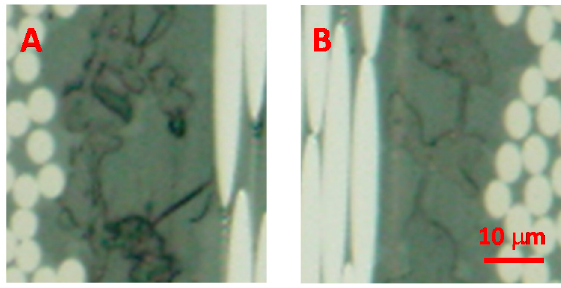
Figure 14. Magnified images of degraded CFRP sample (positions A and B in Figure 13). F igure 14 shows the SAICAS measurement point indicated by red dotted line. SAICAS can measure the cutting force of a blade for a CFRP sample, as indicated in Figure 15. The apparent shear strength can be calculated from the indicated area of the plot of depth versus force, as indicated in equation (1) [24].